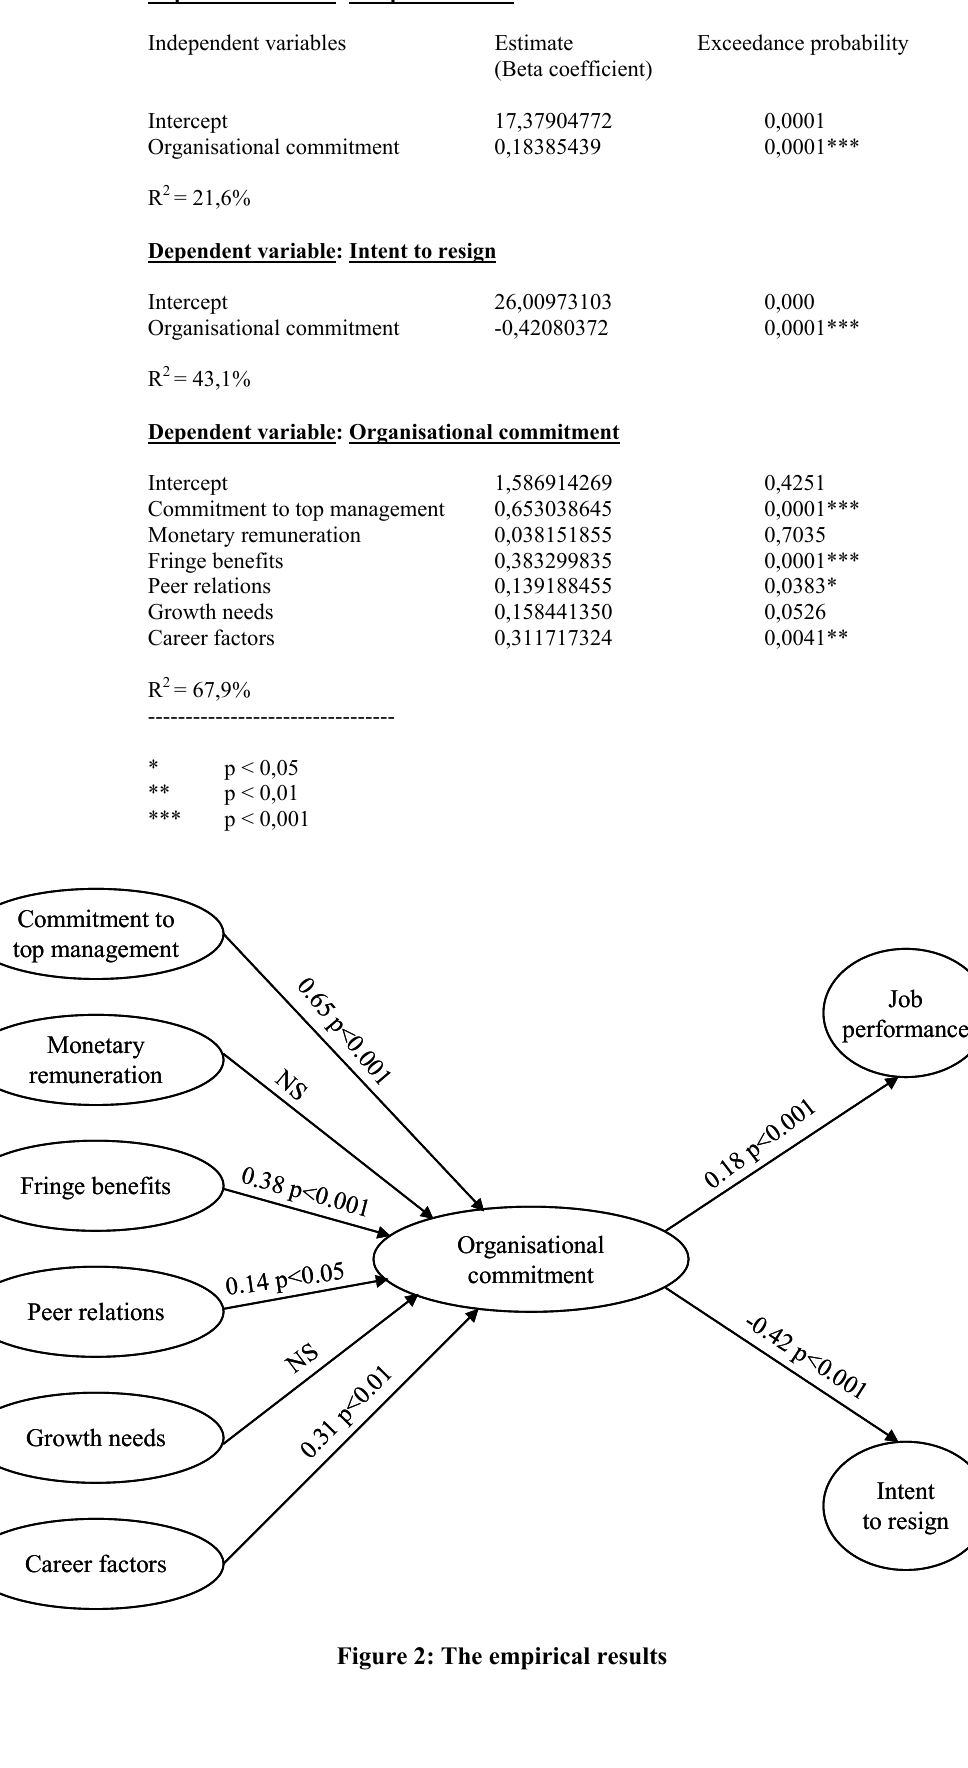
Table 5: Empirical results: Multiple regression analyses